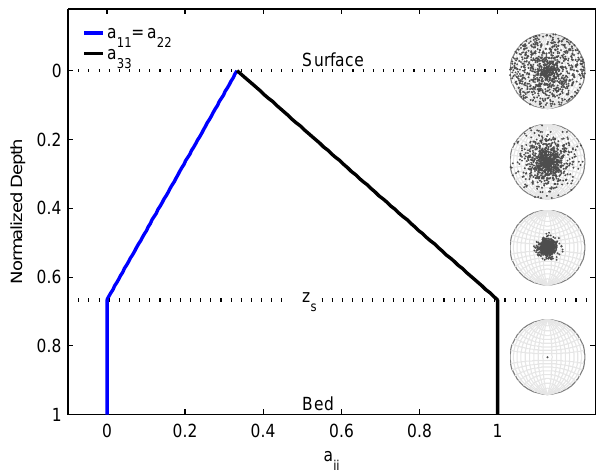
Figure 2. Prescribed fabric distribution with depth. The fabric is represented by the three eigenvalues of the orientation tensor (e.g. Martín and Gudmundsson, 2012), with isotropic ice having a 11 = a 22 = a 33 = 1 / 3 and single maximum with a 11 = a 22 = 0 and a 33 = 1. We also use depth-varying (girdle) fabrics where eigenvalues vary linearly from the surface, where ice is isotropic, to a particular normalized depth z s = {1 / 3 2 / 3}, where we assume single-maximum fabric. The Schmidt diagram of the crystal orien- tations at selected depths is shown on the right side of the figure with the upper plot being isotropic, the lower being single maximum and middle ones being girdle